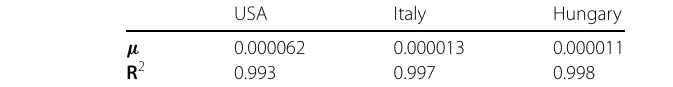
Table 2 Fitting parameters and goodness of the fits shown in Fig. 6, considering the functional form given by equation (16) and fixing a = 7/4